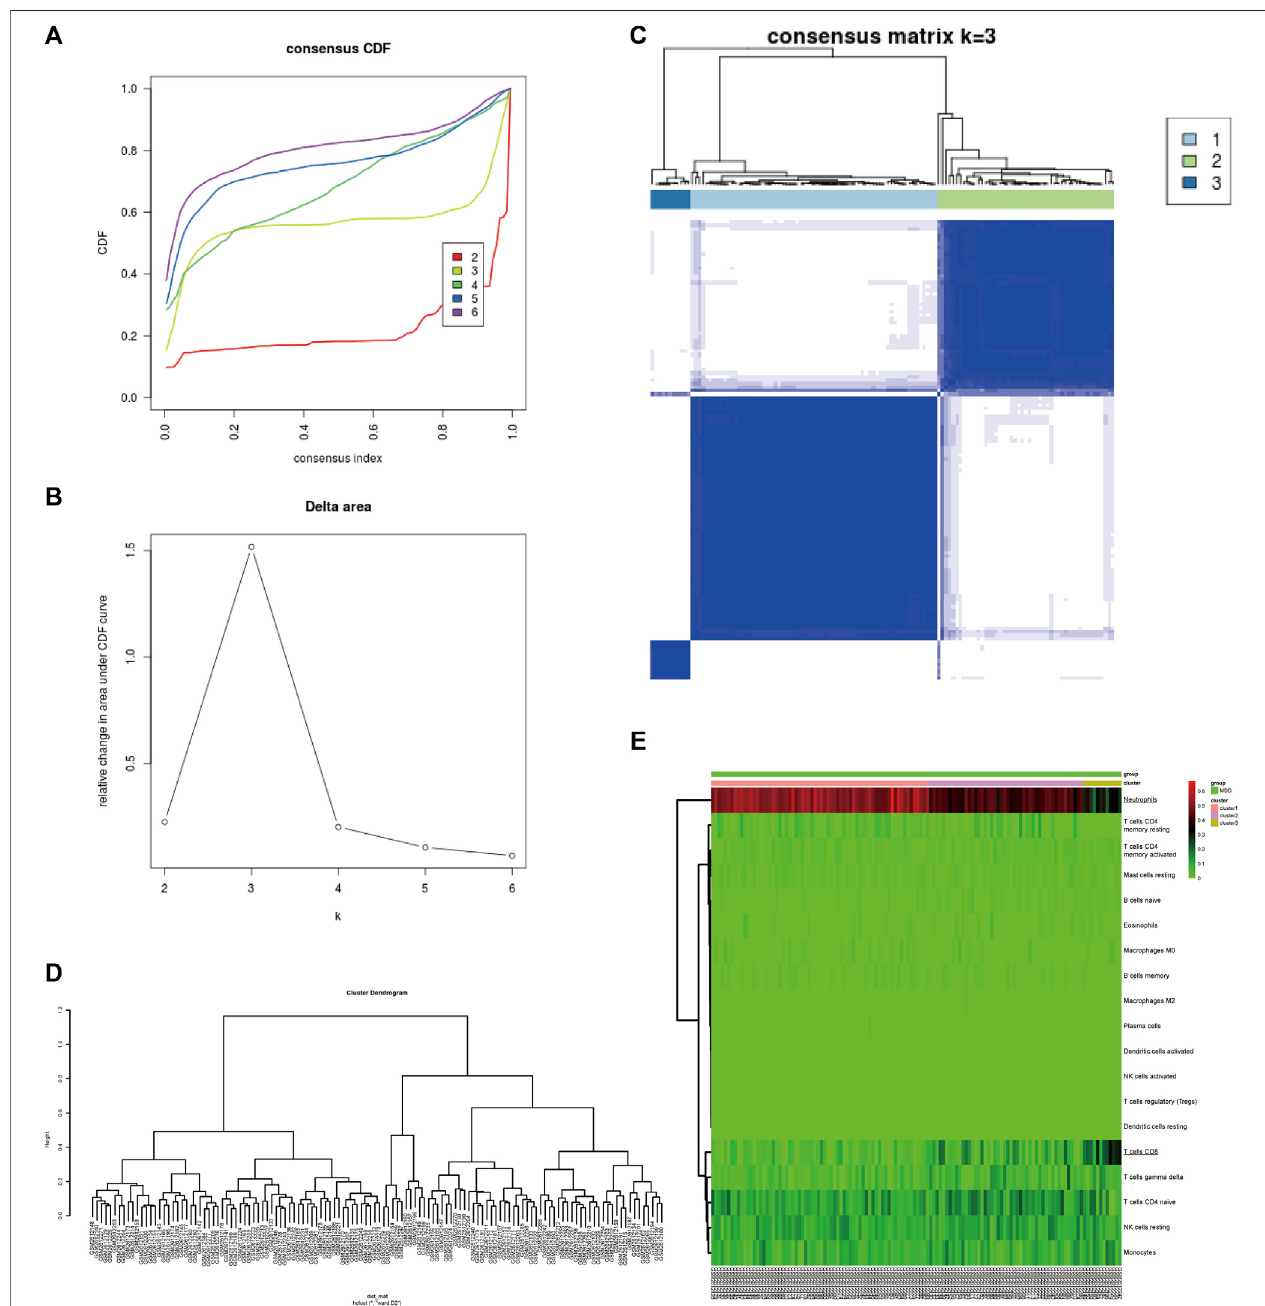
FIGURE 2 | Identi fi cation of MDD subtypes based on IICs in the GSE98793 dataset. (A) The cumulative distribution function (CDF) curves in consensus cluster analysis. Consensus scores for different subtype numbers (k = 2 – 6) are presented. (B) The relative change in area under the CDF curve for k = 2 – 6. (C) The consensus matrix of all samples was distributed into three clusters at k = 3. (D) The cluster dendrogram among all samples. (E) Heatmaps of IICs proportions of each cluster. The higherandlowerexpressedgeneswereshowninredandgreen,respectively,andgeneswiththesameexpressionlevelinblack.IICs,in fi ltratedimmunecells;MDD ( n = 128), major depressive